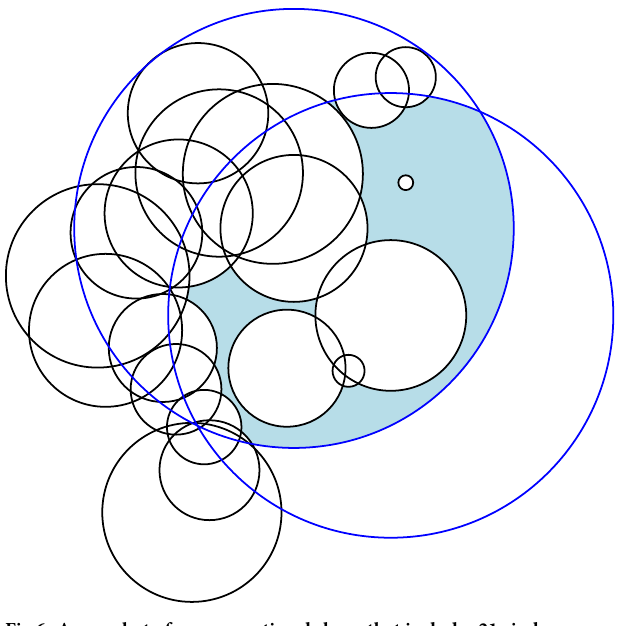
Fig 6. A snapshot of a cross-sectional shape that includes 21